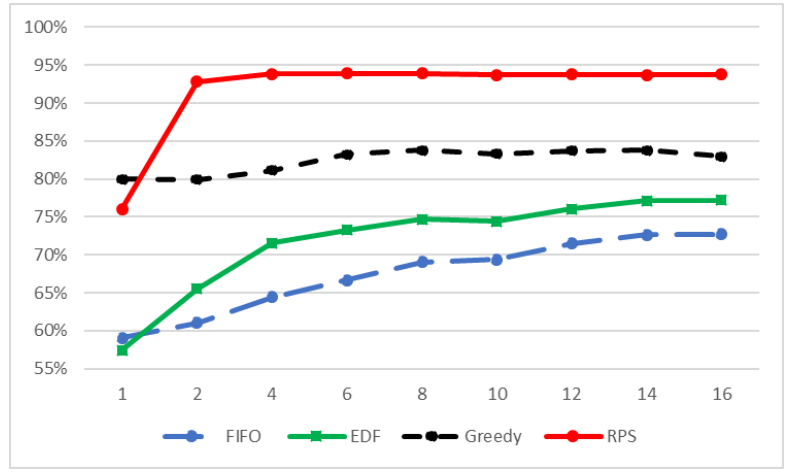
Figure 7. Cumulative rewards’ percentage with different window sizes ( λ a =